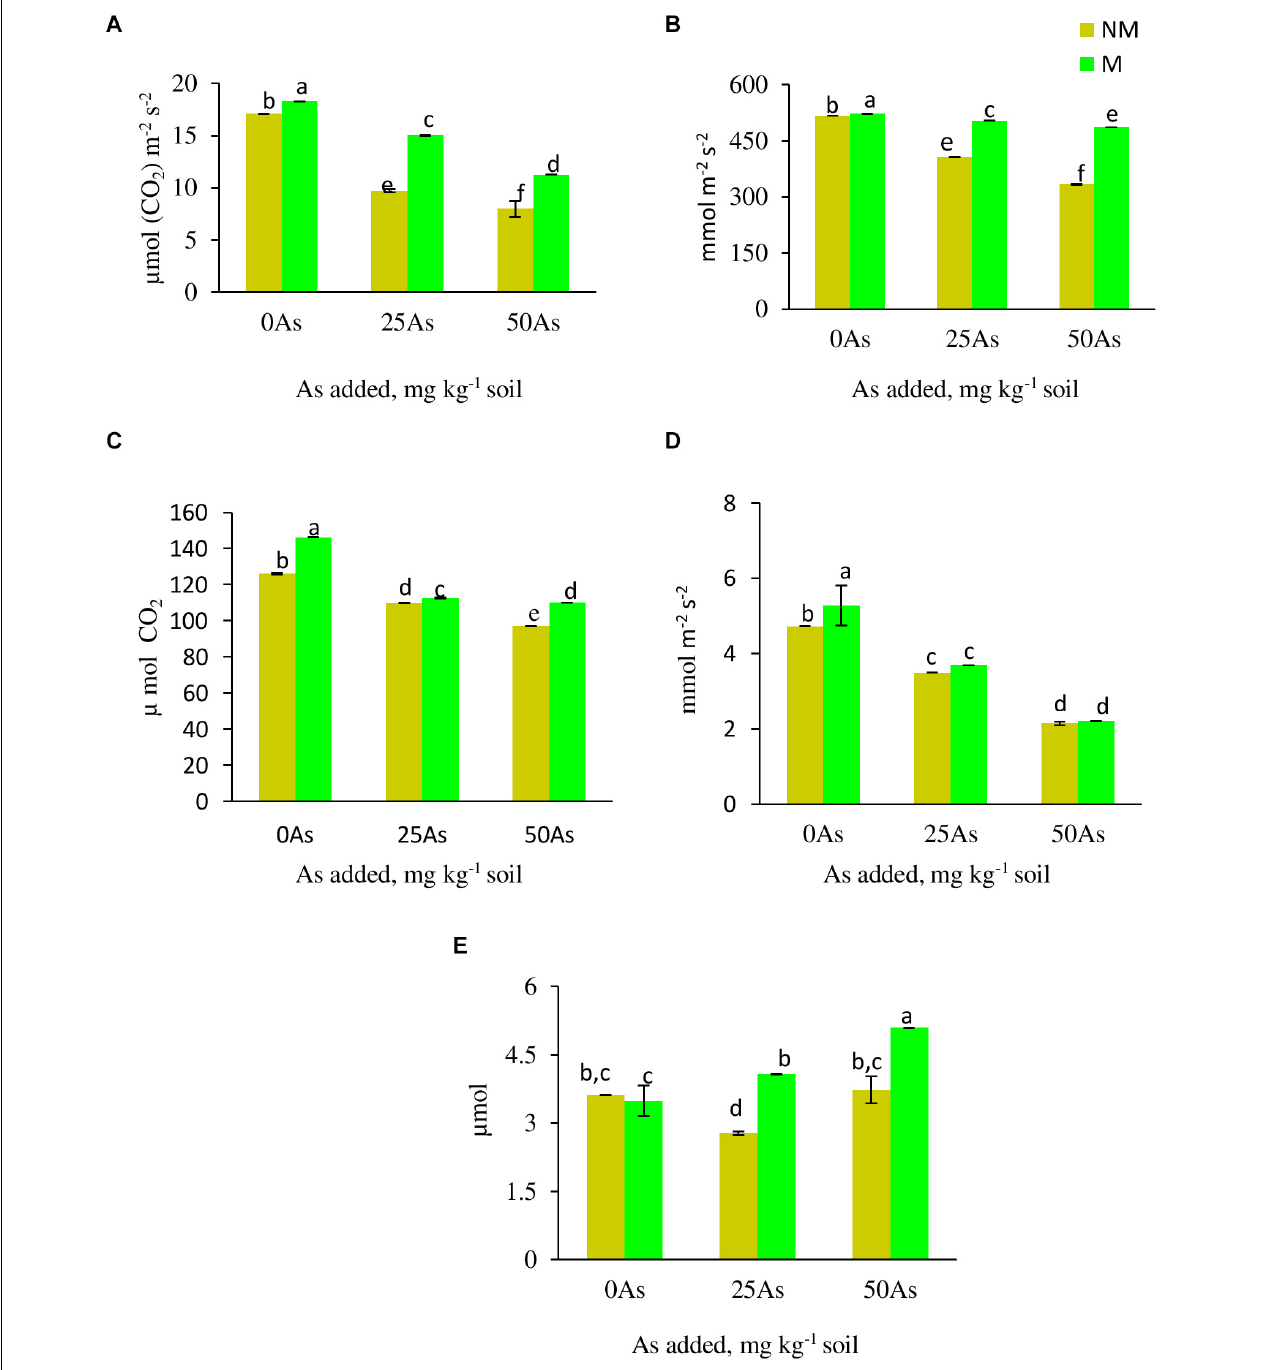
FIGURE 2 | Gas exchange parameters (A) net photosynthetic rate, Pn; (B) stomatal conductance, Gs; (C) intercellular CO 2 concentration, C i ; (D) transpiration rate, E; and (E) water use efficiency, WUE, of Triticum aestivum in response to Rhizophagus intraradices inoculation (M, mycorrhizal; NM, non-mycorrhizal) and As addition to the soil. Values represent means of three biological replicates ± SD. Different letters represent significant difference at p ≤ 0.05 , derived from Tukey’s honestly significant difference (HSD). 0As, 0 mg As kg − 1 soil treatment; 25As, 25 mg As kg − 1 soil treatment; 50As, 50 mg As kg − 1 soil treatment.